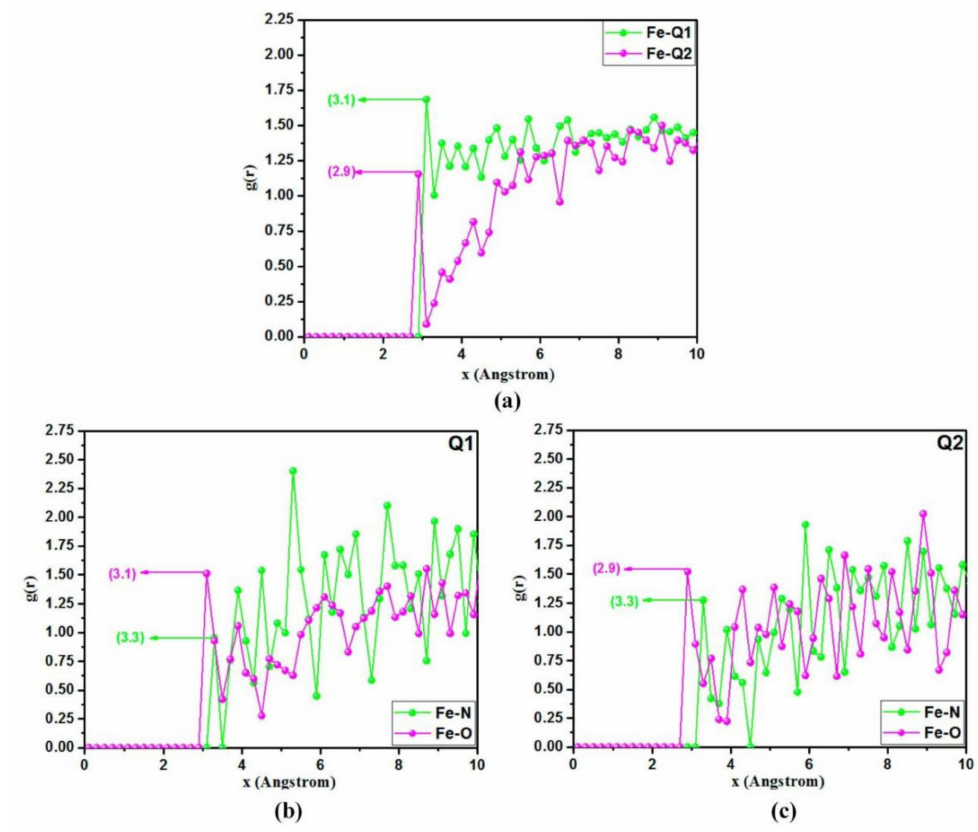
Figure 7. RDF analysis of two quinoxaline derivative inhibitor molecules (Q1 and Q2) on the Fe (110) surface in simulated solution, ( a ) Fe-heteroatoms of Q1, ( b ) Fe-heteroatoms of Q2, and ( c ) Fe-inhibitors. (Reprinted with permission from Ref. [134]. Copyright 2020 MDPI